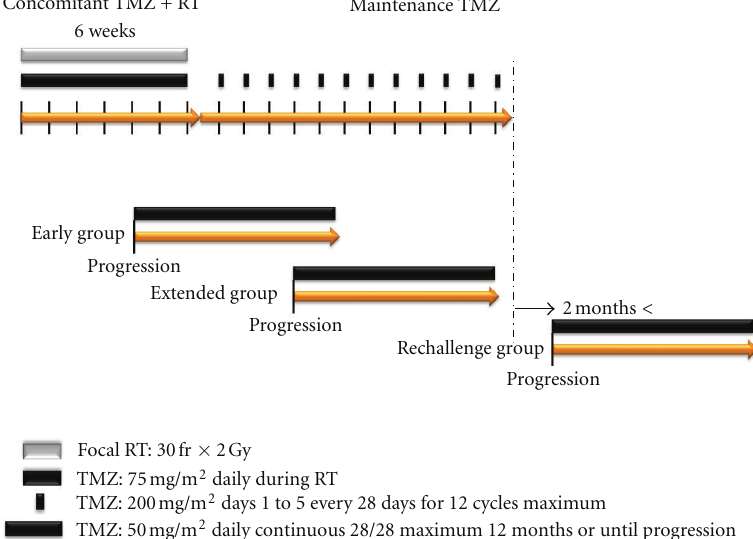
Figure 2: Continuous dose-intense TMZ in recurrent malignant glioma: the RESCUE study. Ninety-one patients with GBM were prospectively divided into 3 groups according to the timing of progression during adjuvant therapy: early, extended, and